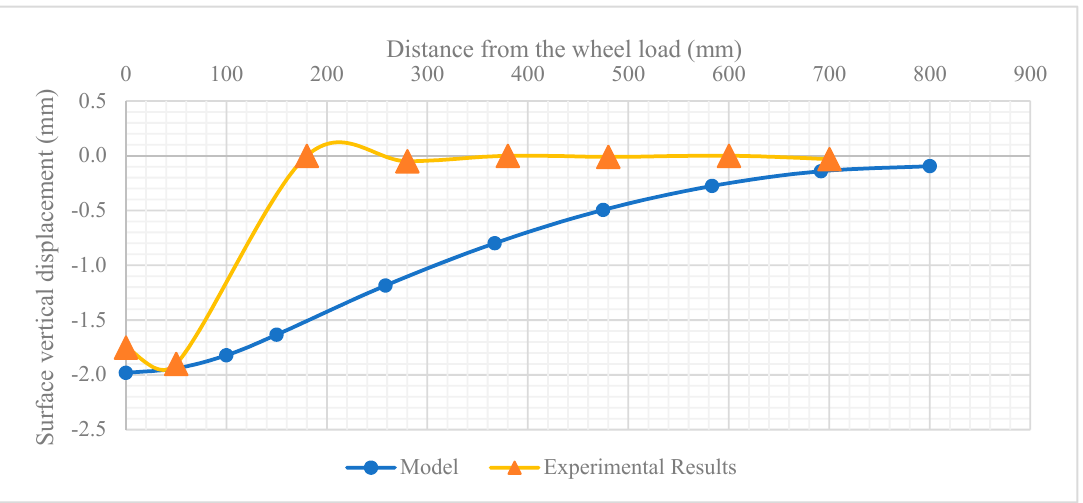
Figure 3. Final rutting profile from the lab experiment and predicted model.